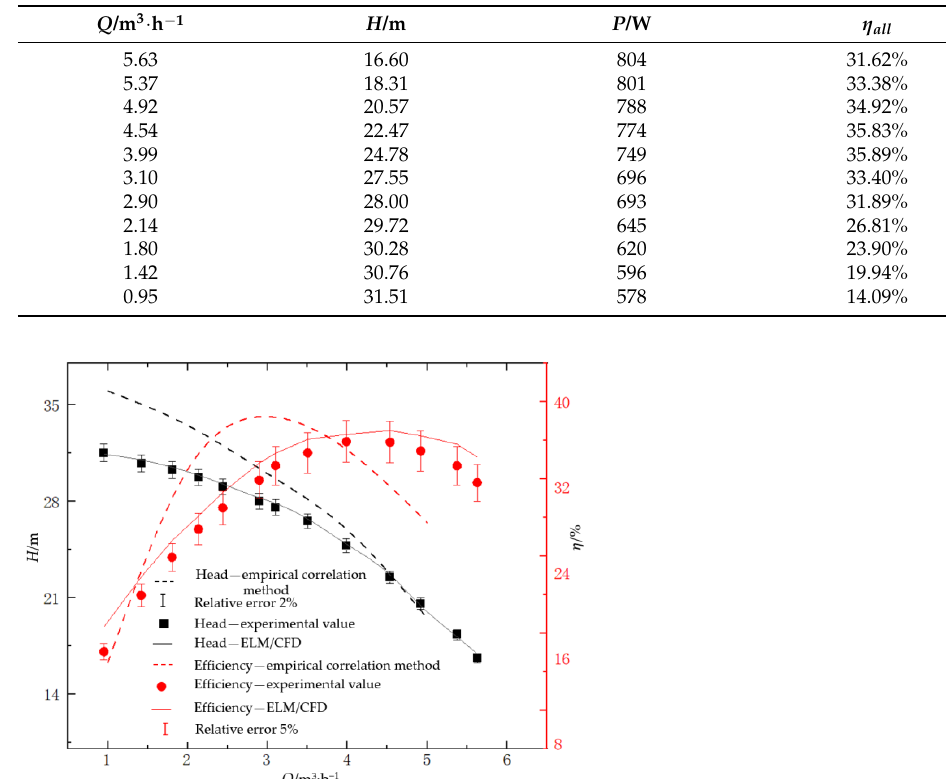
Table 3. Measurement results of low specific speed high-speed centrifugal pump.